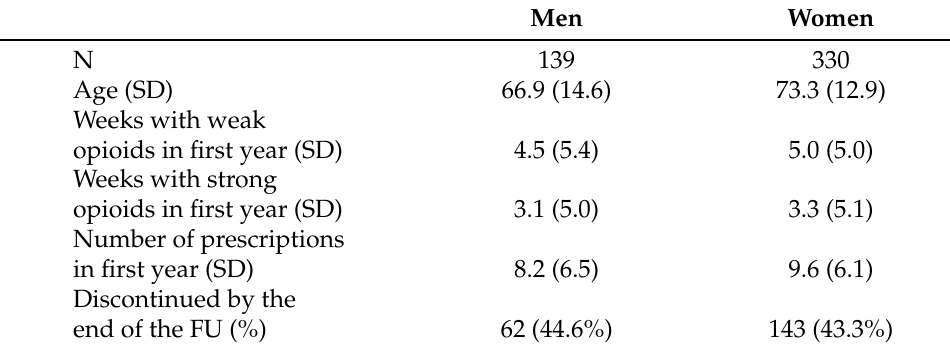
Figure 1. State distribution plot. Evolution of the proportion of patients using different types of opioids during the first year of therapy. Table 2. Characteristics of the sample.